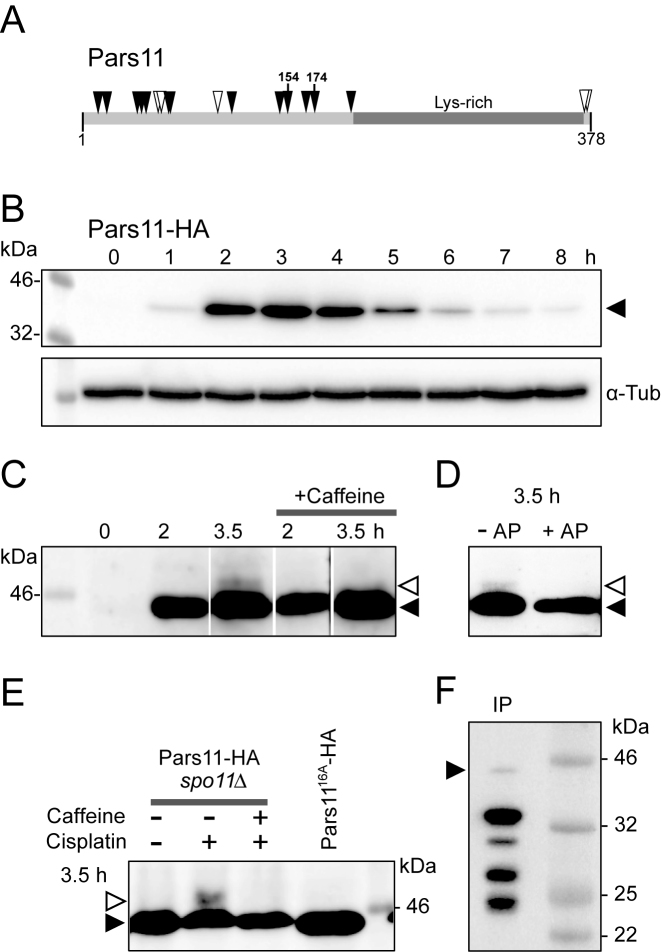
(A) Pars11 protein organization. Solid arrowheads: SQ motifs, open arrowheads, TQ motifs. Ser154 and Ser174 are confirmed phosphoepitopes. (B) Western blot showing a protein band of the size expected for HA-tagged Pars11 (∼44 kD—solid arrowhead), with maximal intensity at 3 h after induction of meiosis (corresponding to early−mid-prophase) and α-tubulin as the loading control. (C) High-resolution SDS-PAGE reveals a caffeine-sensitive (i.e. possibly ATR-dependent) modified Pars11 form (open arrowhead) during late prophase (3.5 h after induction of meiosis). Lanes in panel C were rearranged to improve comprehensibility. The unprocessed gel is shown in Supplementary Figure S4B. (D) The modified Pars11 form is sensitive to alkaline phosphatase (AP). (E) Pars11 remains non-phosphorylated (solid arrowhead) in spo11Δ, but phosphorylation (open arrowhead) is induced by the DNA damaging agents cisplatin, and is suppressed by the ATR inhibitor caffeine. Pars1116A remains also unphosphorylated. (F) After immunoprecipitation (IP) most Pars11-HA is degraded (solid arrowhead indicates intact protein).